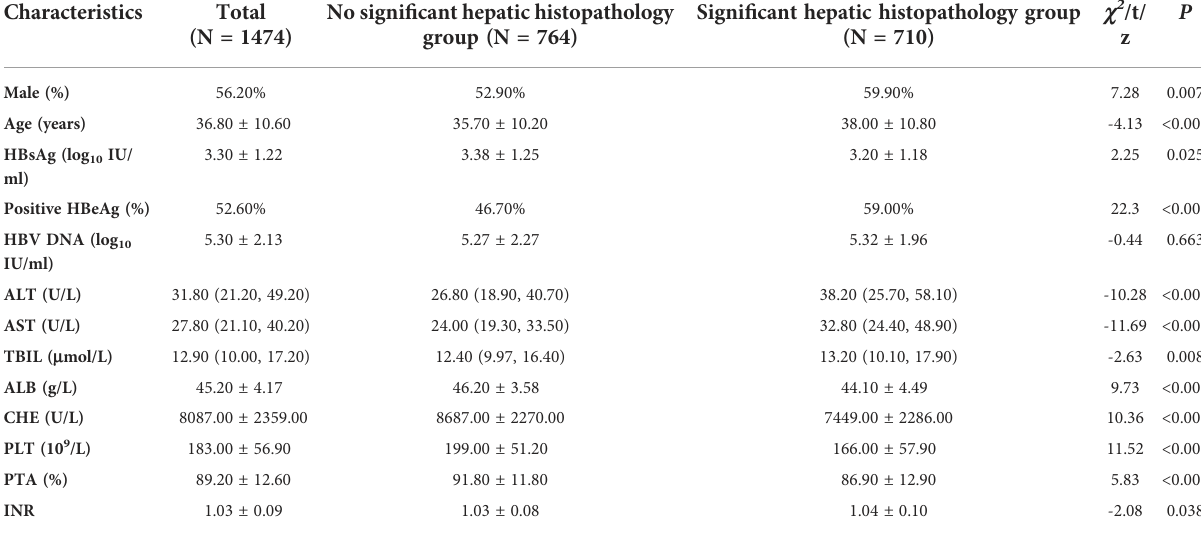
TABLE 1 Overall patients ’ clinical characteristics and their comparisons between patients with and without signi fi cant hepatic histopathology. Characteristics